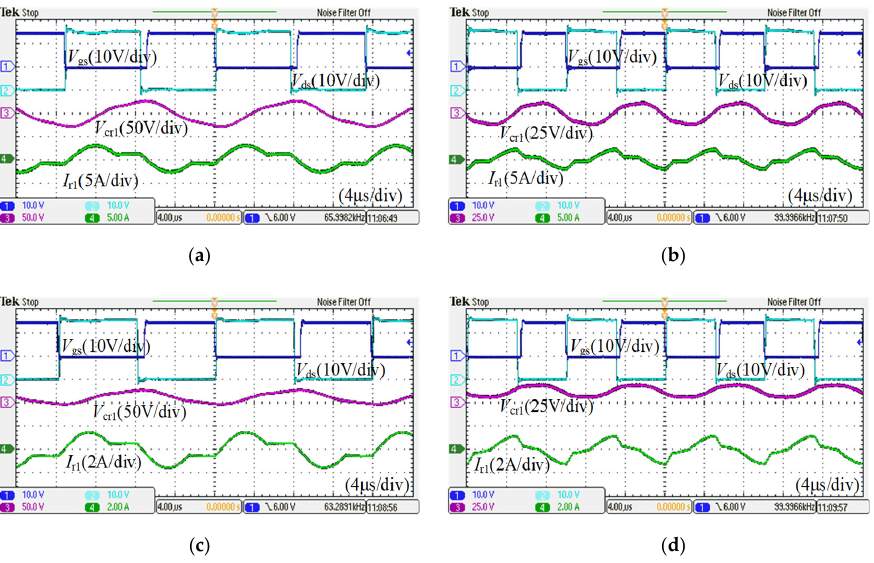
Figure 16. ZVS experimental verification waveform. ( a ) Full ‐ bridge FM mode; ( b ) full ‐ bridge phase ‐ shift mode; ( c ) half ‐ bridge FM mode; ( d ) half ‐ bridge phase ‐ shift mode.